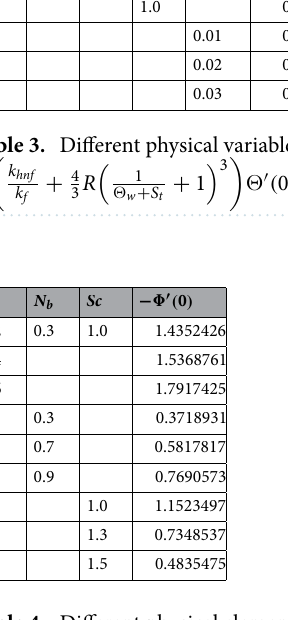
Table 4. Different physical elements have an impact on the Sherwood number, 1 2 [ Re r ]